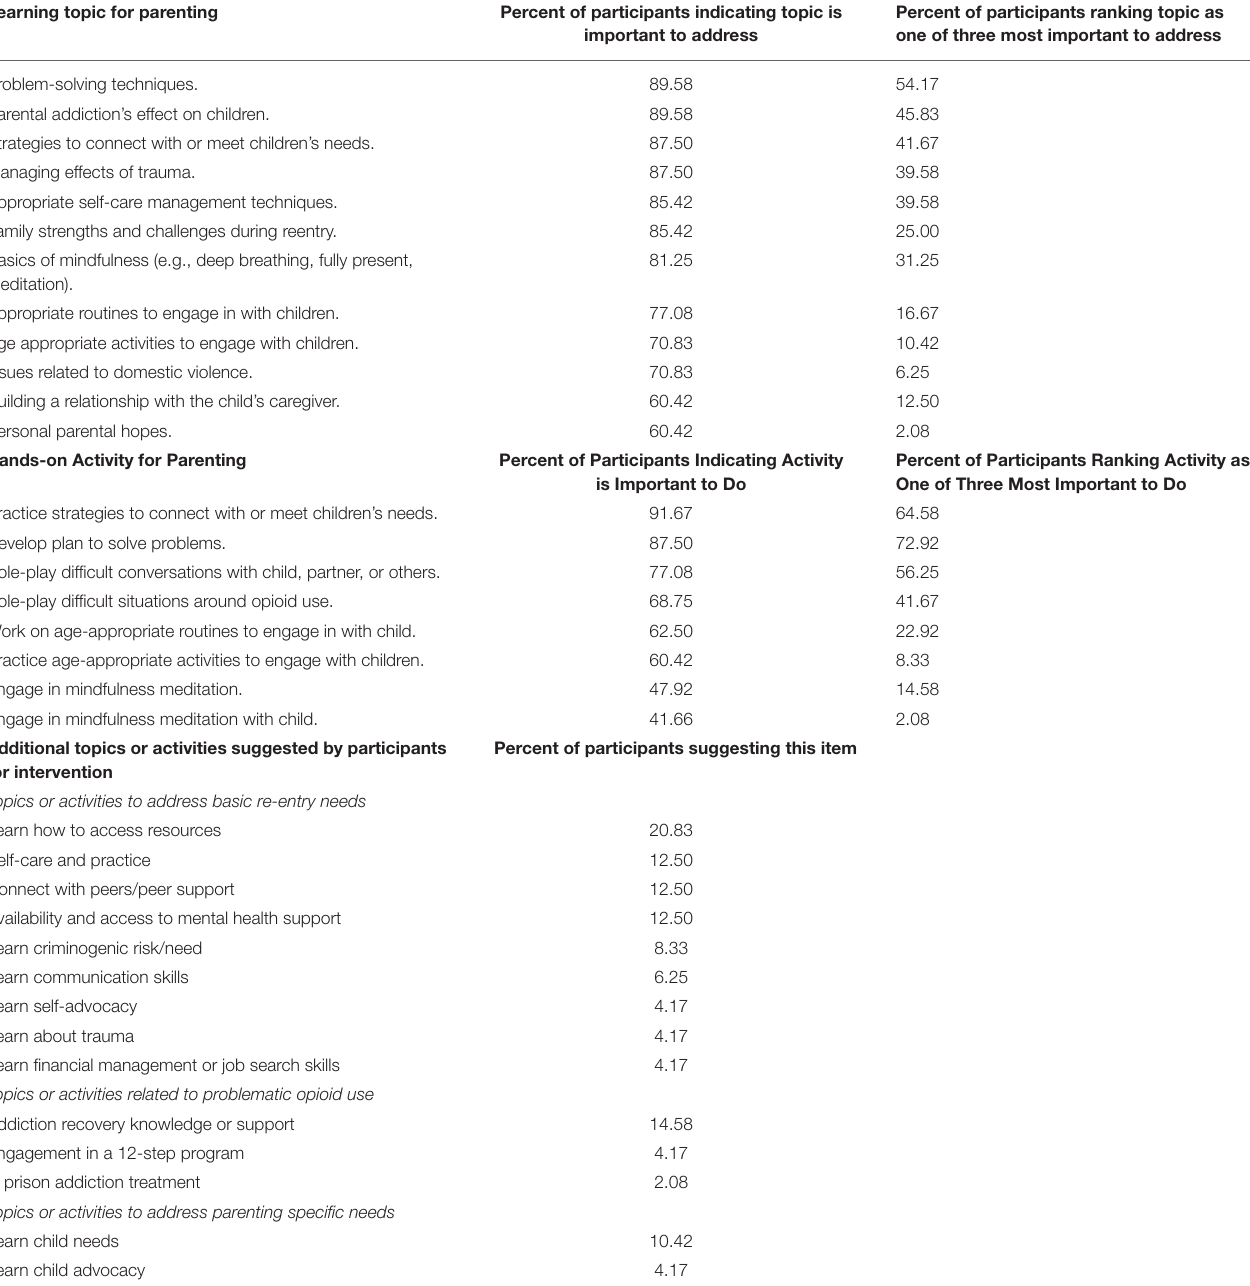
TABLE 4 | Important topics and activities for reentering parents with opioid addiction. Learning topic for